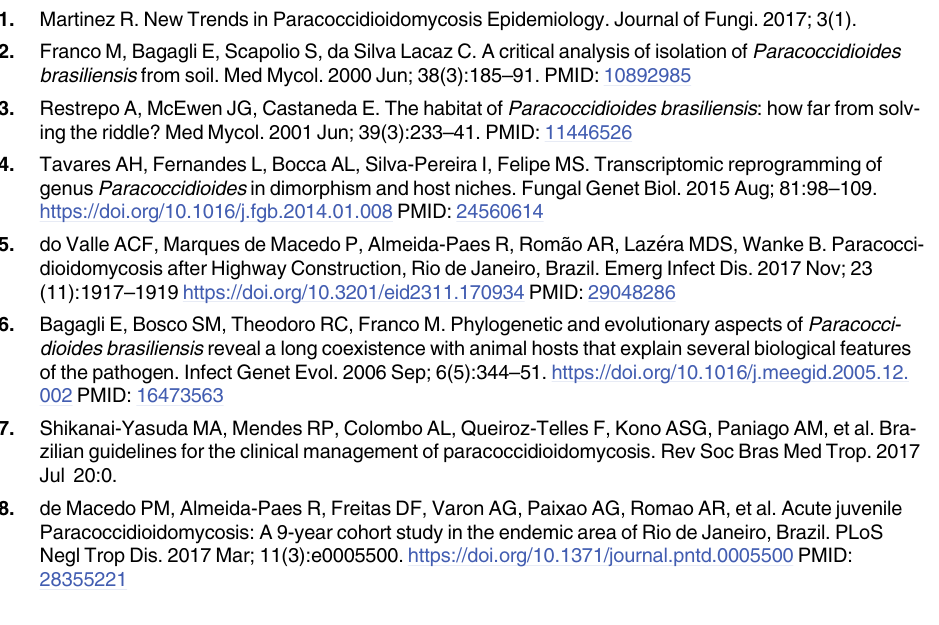
S1 Table. Accession numbers of the Paracoccidioides sequences analyzed in this